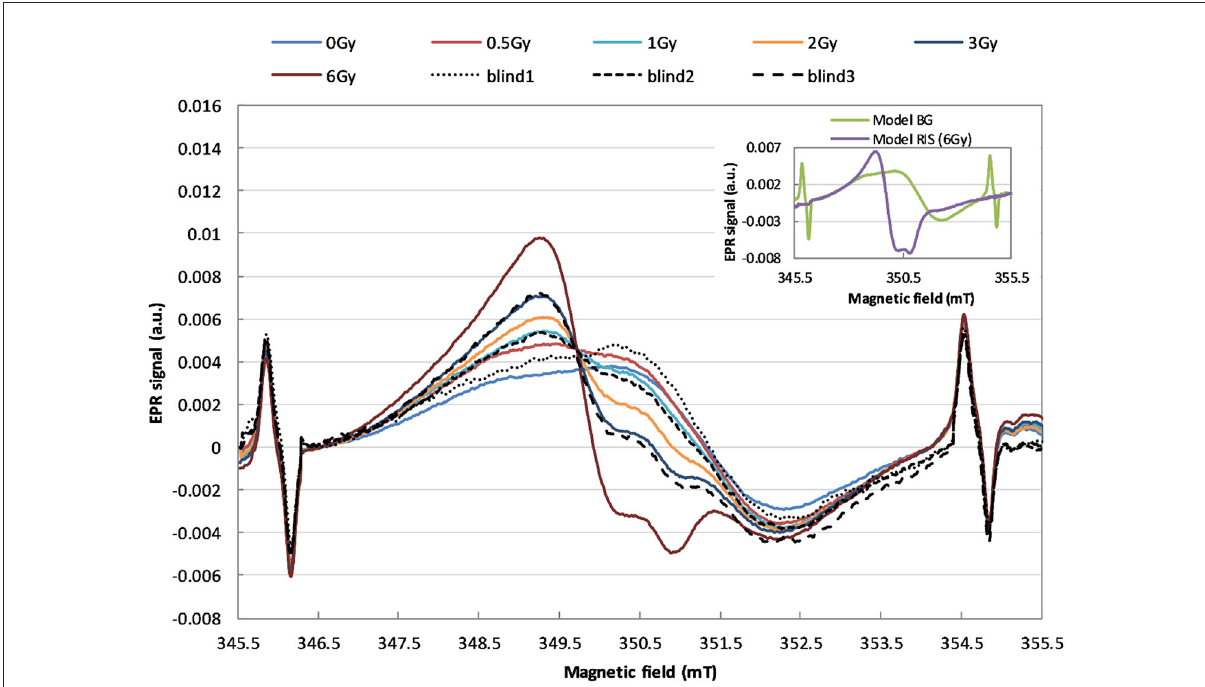
FIGURE3 EPR spectra demonstrating the effect of irradiation of the watch glass with 240 keV X-rays with doses in the range of 0–6Gy (in terms of kerma in air). The solid lines refer to the calibration samples, the dashed and dotted lines refer to the blind samples.